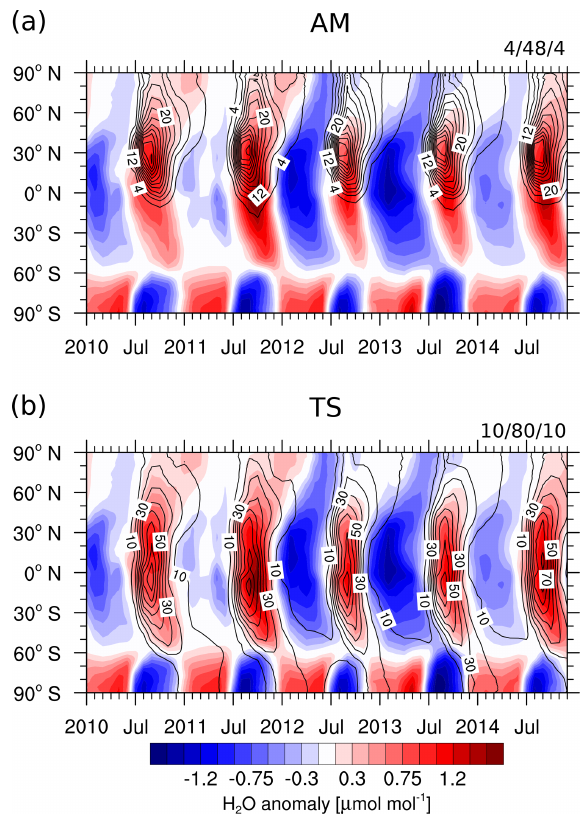
Figure 9. (a) Horizontal water vapour tape recorder (colour-coded) as temporal anomalies from the zonal means (in µmolmol − 1 ) and corresponding relative contribution (in %) of the Asian mon- soon (AM) tracer to water vapour at 400K (black contours). Numbers in the top right corner indicate the contour line spac- ing as min/max/delta. Wet (dry) phases are shown in red (blue) and the strongest positive (negative) anomalies above (below) 1.5 ( − 1 . 5)µmolmol − 1 are coloured in dark red (blue). (b) As in (a) but for the TS